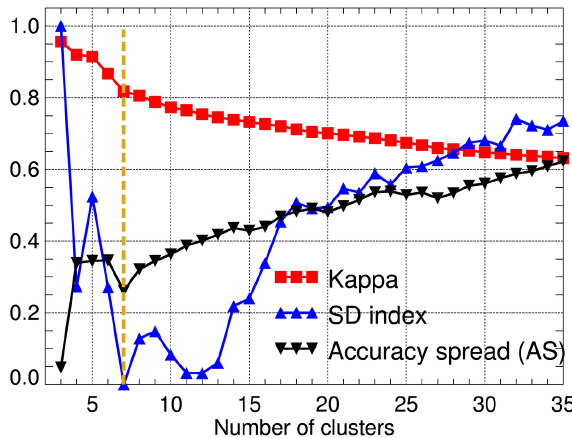
Figure 3. Evolution of kappa, accuracy spread (AS) index, and SD index as a function of the number of clusters in the data set. The SD index is stretched between 0 and 1 for illustration purposes. The yel- low vertical line at n c = 7 shows the selected final number of clus- ters, corresponding to a minimum AS and SD. Each curve shows the mean behaviour over 100 runs of the clustering